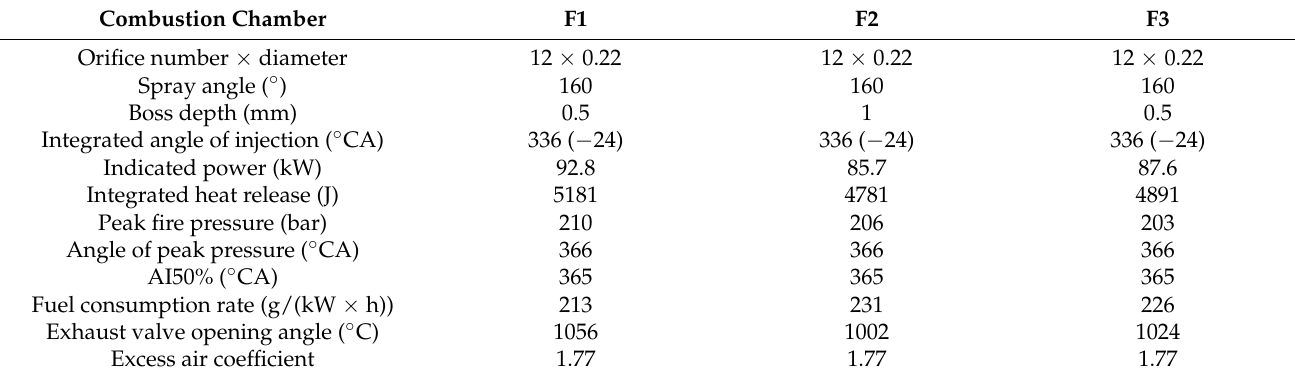
Table 14. Comparison of engine performance parameters of three combustion chamber schemes matched with a 160 ◦ spray angle